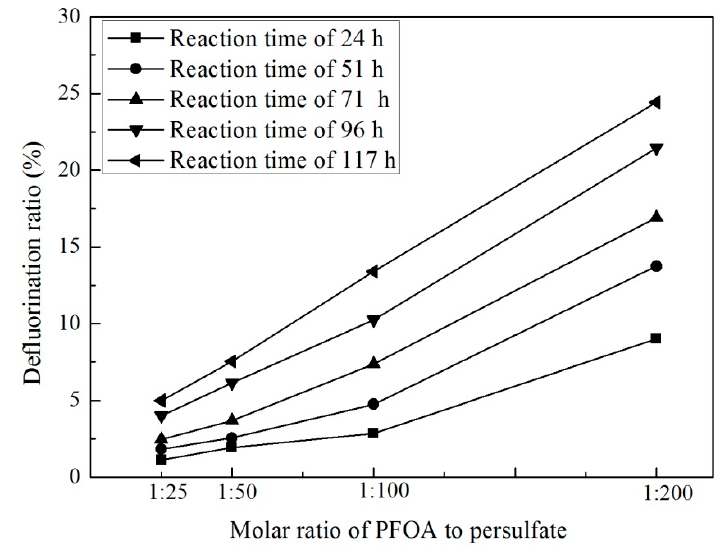
Figure 2. Comparison of PFOA degradation given different concentrations of persulfate ([PFOA] 0 = 20 μ M; temperature = 40 °C; molar ratio of PFOA to persulfate are 1:25, 1:50, 1:100 and 1:200; pH adjusted by H 2 SO 4 to 2.0).